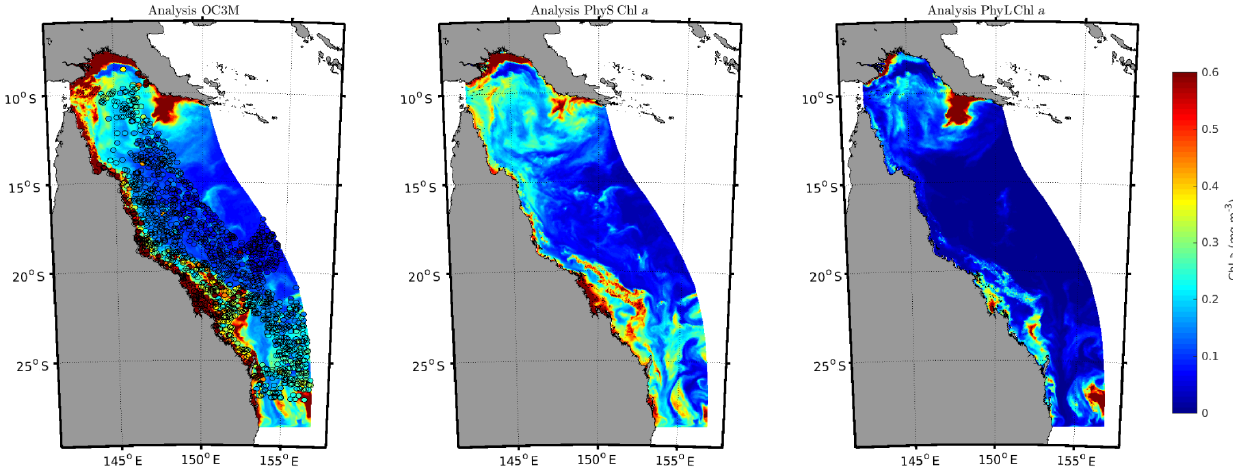
Figure 15. The resulting analysis fields for simulated OC3M and withheld ANN OC3M observations for EXP4 (cycle 22) overlaid (left) and the analysis fields for the prognostic variables of small phytoplankton (centre) and large phytoplankton (right) for the 12 September 2013. Table 4. Root mean square differences (RMSDs) for the withheld observations and the control run (control) and assimilation experiment 2 (EXP2), experiment 4 (EXP4) and experiment 5 (EXP5). The lowest RMSD is given in bold. Observed